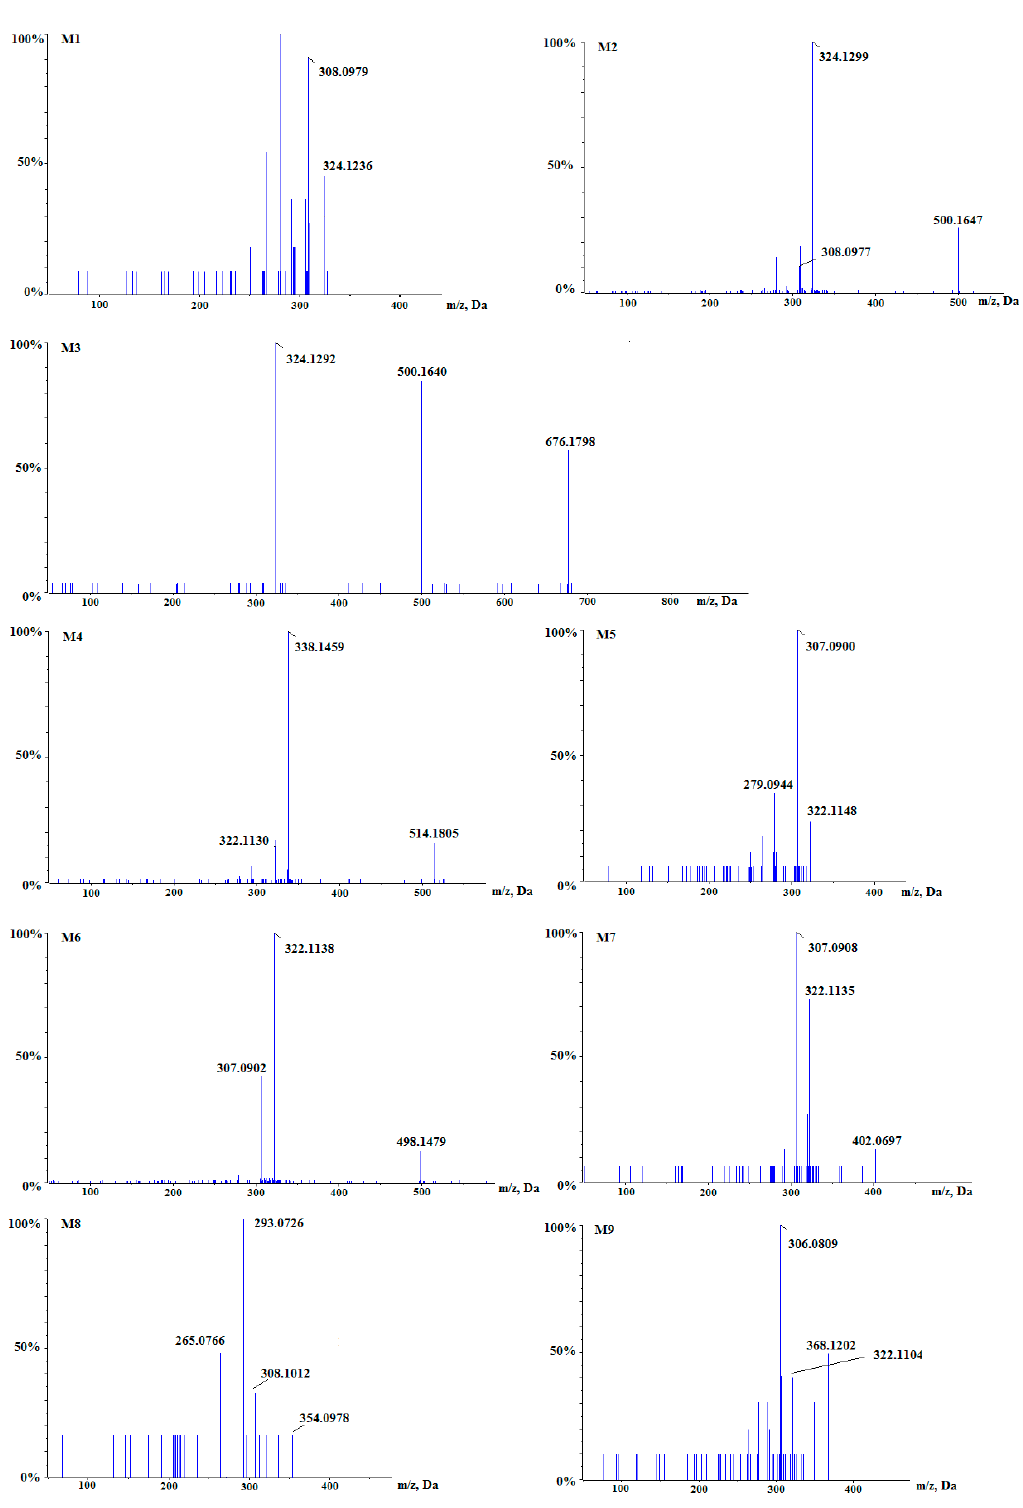
Figure 4. The MS 2 spectra of berberine metabolites M1–M9 in rat plasma.